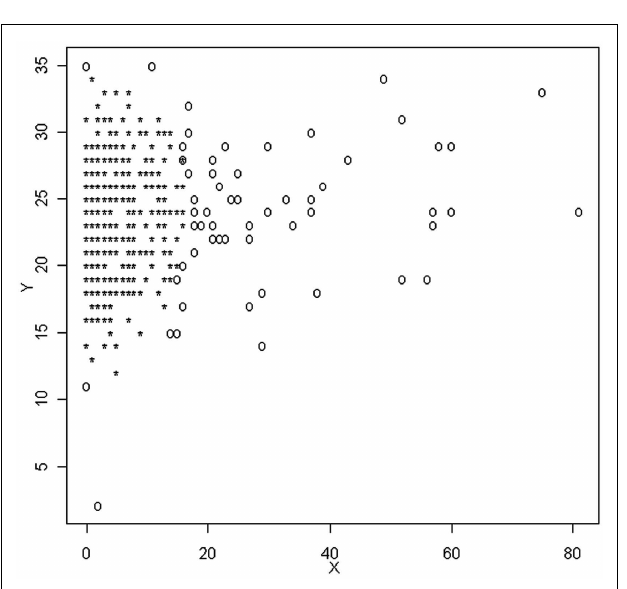
FIGURE 3 | Scatterplot of observations identified as outliers based on the MGV